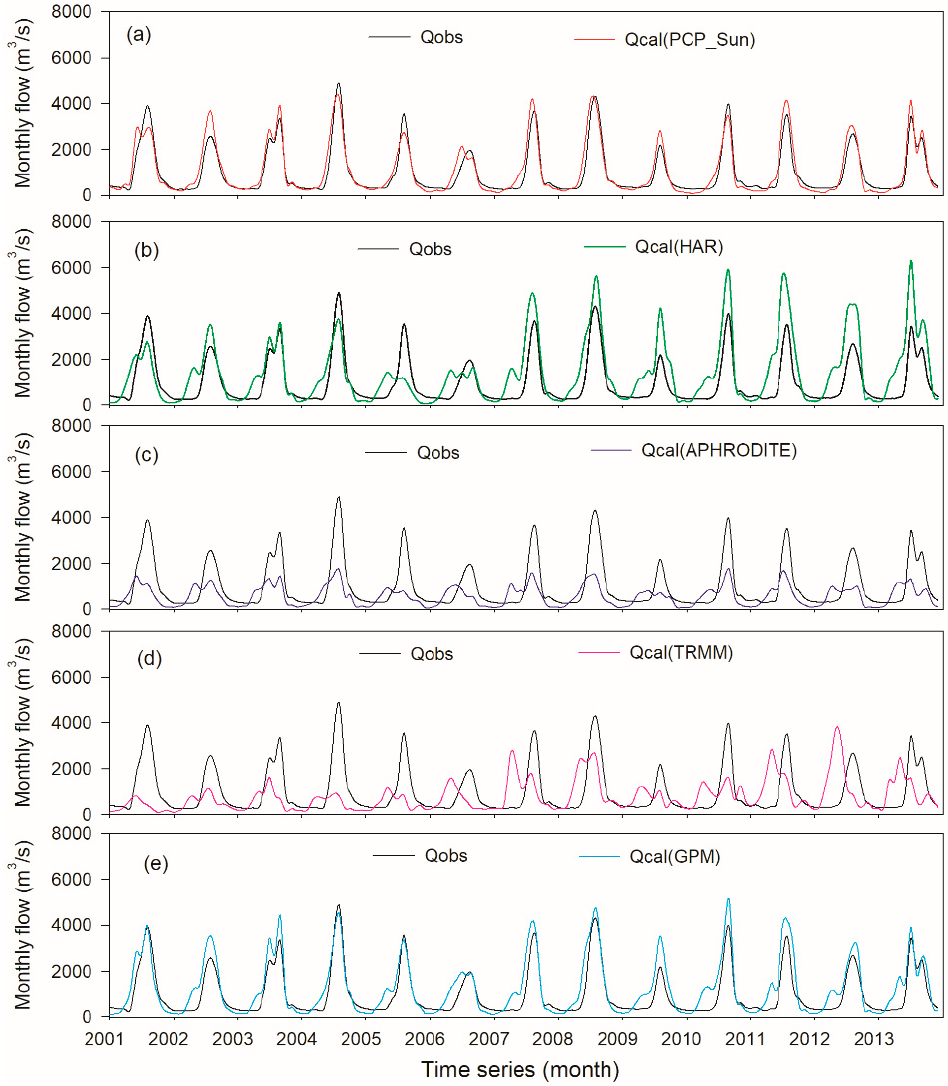
Figure 11. Monthly flow simulation driven by ( a ) reference precipitation and four precipitation datasets: ( b ) HAR, ( c ) APHRODITE, ( d ) TRMM and ( e ) GPM, at Yangcun hydrological station during years 2001–2013.